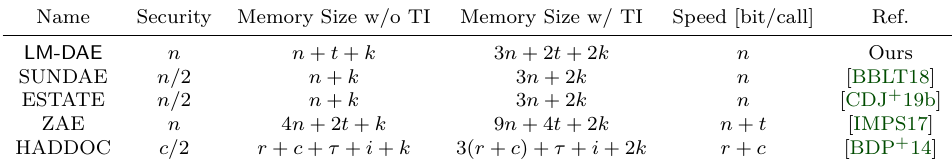
Table 1: Security, memory size with and without TI, and speed, where k : key size; n : block size of (T)BC; t : tweak size of TBC; r : rate; c : capacity; τ : tag size; i : counter size. Note that r , c , τ and i are the parameters of HADDOC, and r + c is the permutation size. This table assumes that t ≥ n . The entries for speed show block sizes in bits for each primitive call in hashing phases.